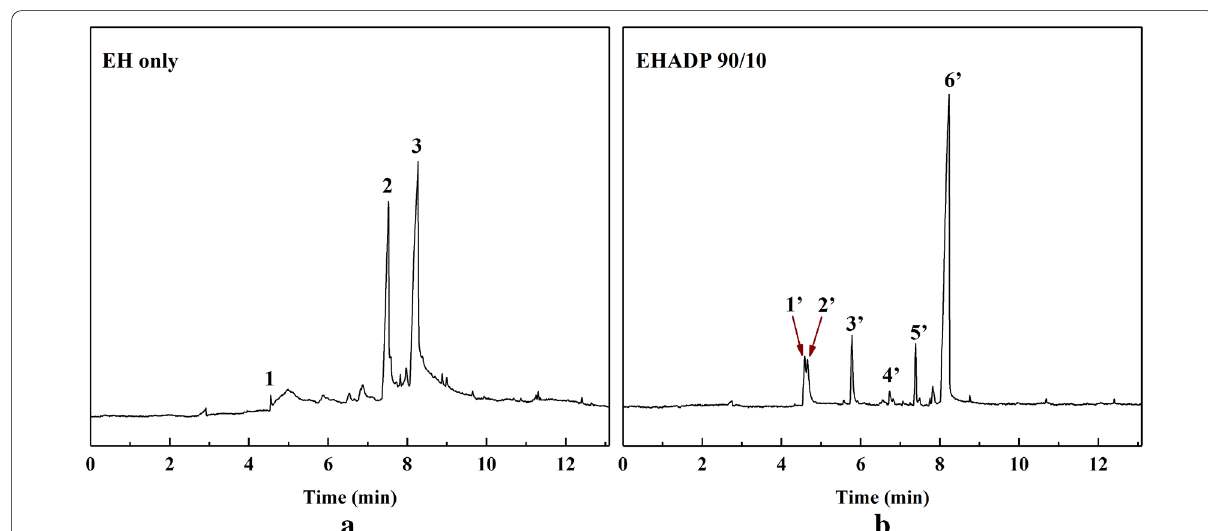
Fig. 6 GC/MS chromatogram of evolved gas taken from the uncured a EH and b EHADP adhesive heated at 170 °C for 60